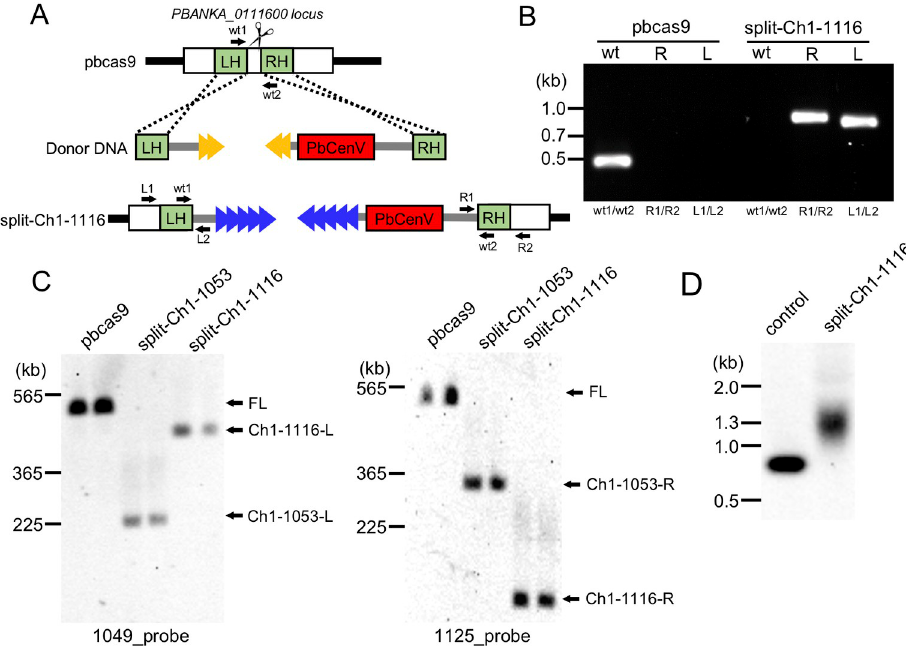
Fig 2. CRISPR/Cas9-based chromosome split. (A) The PBANKA_011600 was cleaved by the Cas9-sgRNA complex, followed by HDR with the donor template DNA including only telomere, and telomere and centromere. (B) The genotyping PCR was performed using the sets of primers indicated at the bottom. (C) Southern hybridization analyses of the transgenic parasites, which are split-Ch1-1116 and -1053, detected the split chromosomes. The probe DNA used in each analysis is shown at the bottom. The information about the probe are described in S2 and S3 Figs. (D) Southern hybridization shows the telomere extension in the transgenic parasite.